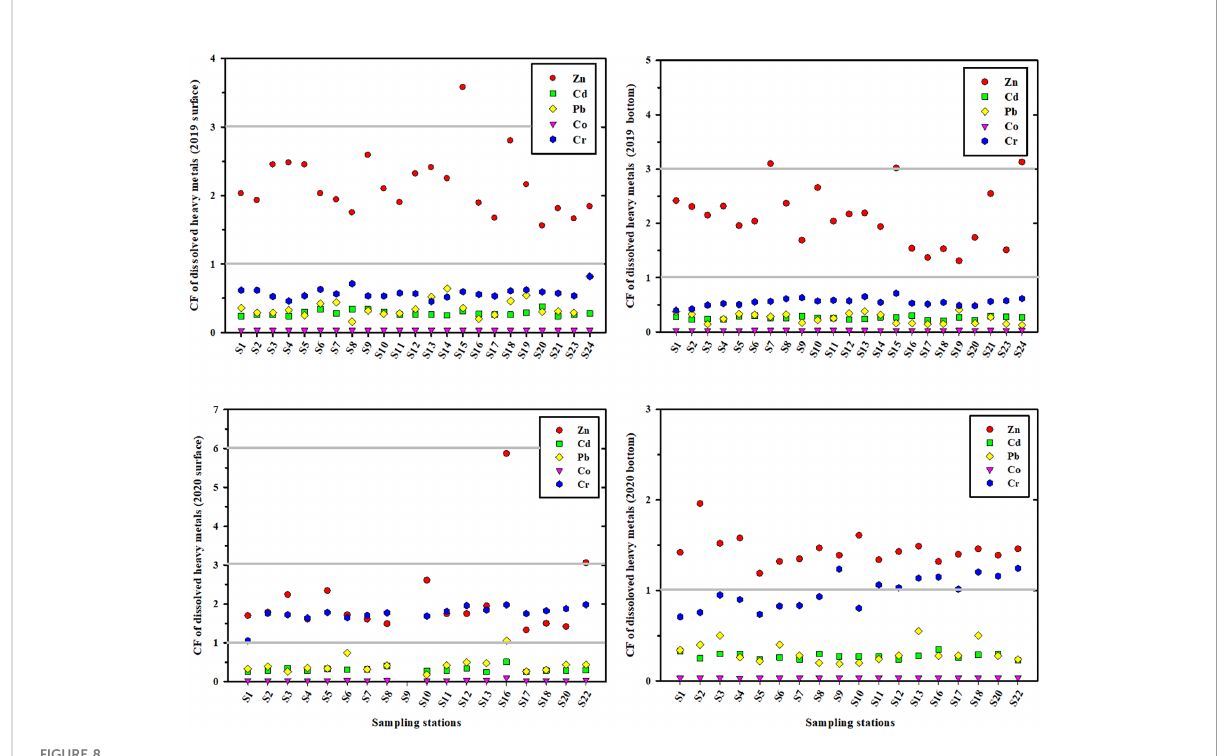
FIGURE 8 CF and CD for the dissolved trace metals in the